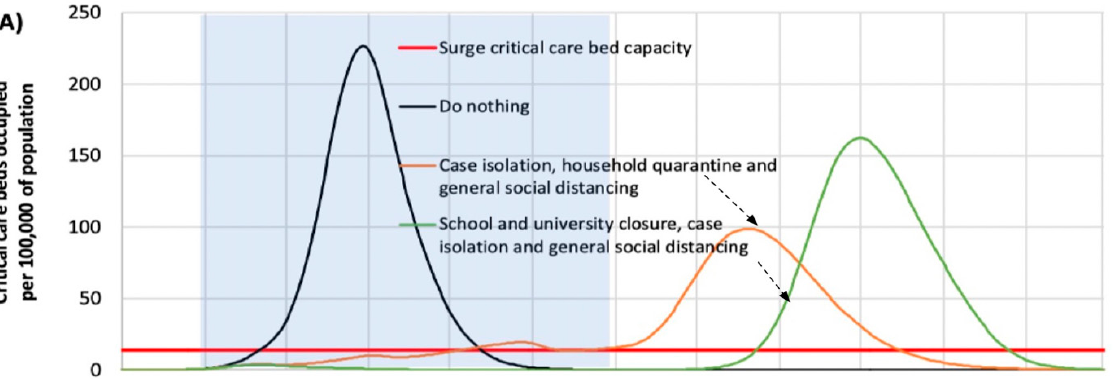
Figure 2. Early projection of COVID-19 patients in critical care with and without mitigation. Source: [43].